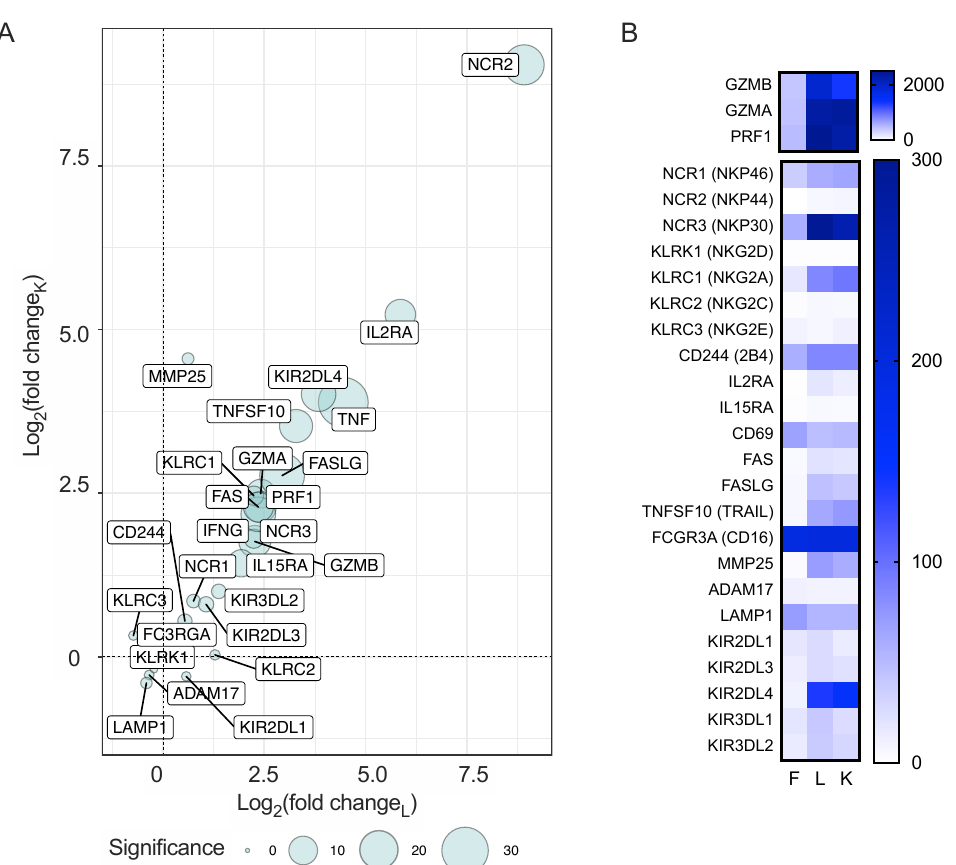
Figure 2. Ex vivo expansion of NK cells leads to a highly significant transcriptional alterations in genes that are crucial for NK cell cytotoxicity. ( A ) Bubble plot that displays genes that control NK cell cytotoxicity. Axis values represent log 2 -transformed fold change of transcript expression in expanded NK cells compared to fresh NK cells, where L = LCL-expanded NK cells and K = GE-K562-expanded NK cells. The size of the bubble corresponds to the log 10 -transformed adjusted p value to denote the statistical significance of differential expression, based on LCL-expanded NK cell values. ( B ) Heat maps that display Fragments Per Kilobase of exon model per Million mapped reads (FPKM) values of the genes that are graphed in ( A